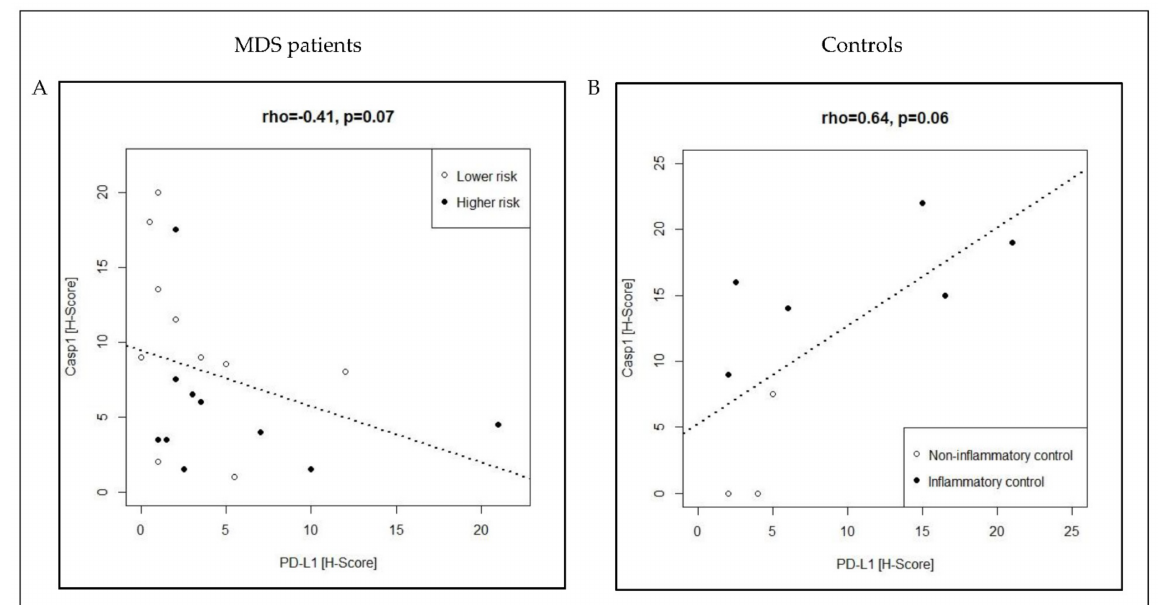
Figure 2. Relevant correlations between immune-related biomarkers in MDS patients ( A ) and controls ( B ). Regression analysis was performed with Spearman’s rank correlation and significance determined using Bonferroni correction. Refer also to Table